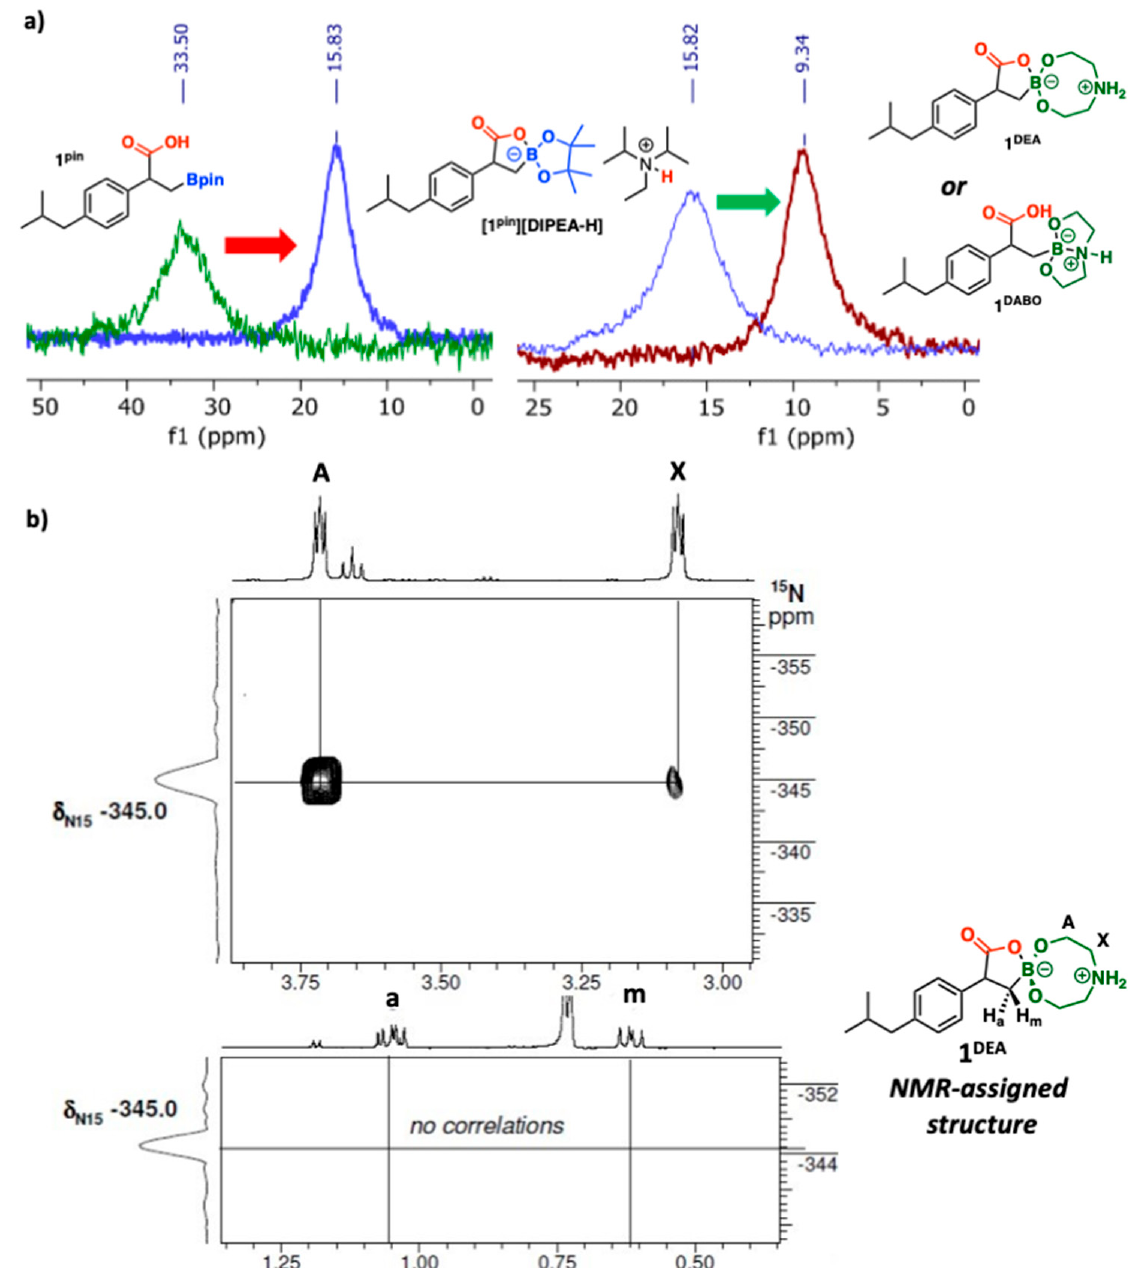
DABO methyl boronate (Figure 3b and Figure S6). The heteronuclear inverse-correlation experiment was optimized to reveal vicinal ( 3 J), and to a lesser extent geminal ( 2 J) 1 H- 15 N coupling. The DEA boronate CIGAR spectrum showed two- and three-bond correlations to the DEA AA’XX’ spin system (Figure 3b). In contrast, the DABO methyl boronate CIGAR spectrum showed three-bond correlations to the DEA AB spin system, as well as a three-bond correlation, across the 11 B nucleus, to the methyl group. These NMR experiments collectively confirm that DEA boronate adopts the spirocyclic boralactonate structure ( 1 DEA ) rather than the DABO boronate structure ( 1 DABO ).